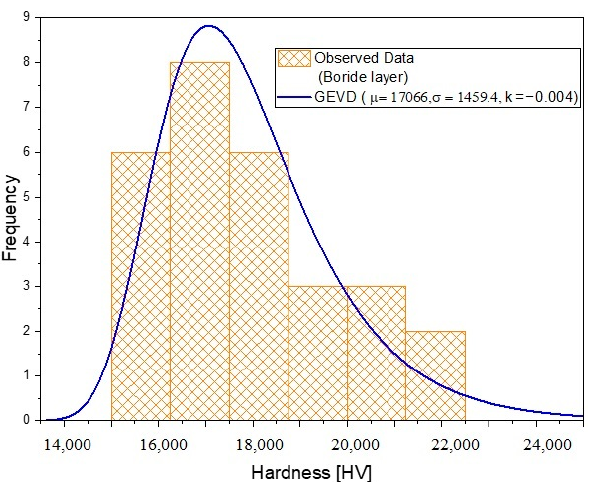
Figure 8. Boride layer micro-hardness histogram fitted to generalized extreme value distribution.